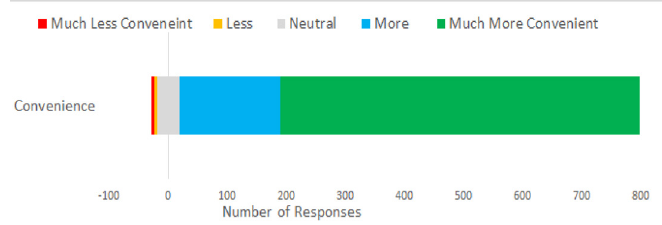
Figure 4. Patients’ impression of the convenience of the drive- through medical system compared to an emergency department